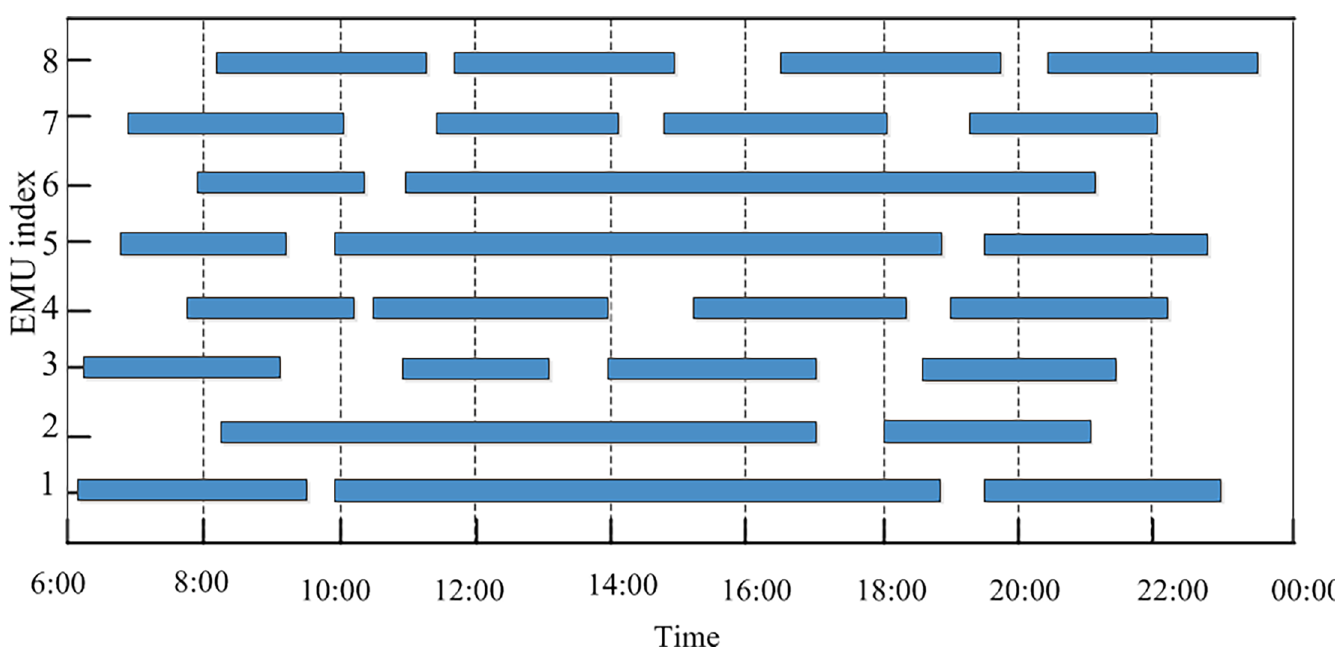
Fig 8. Gantt chart of the train tasks assigned to each EMU in the collaborative mode.